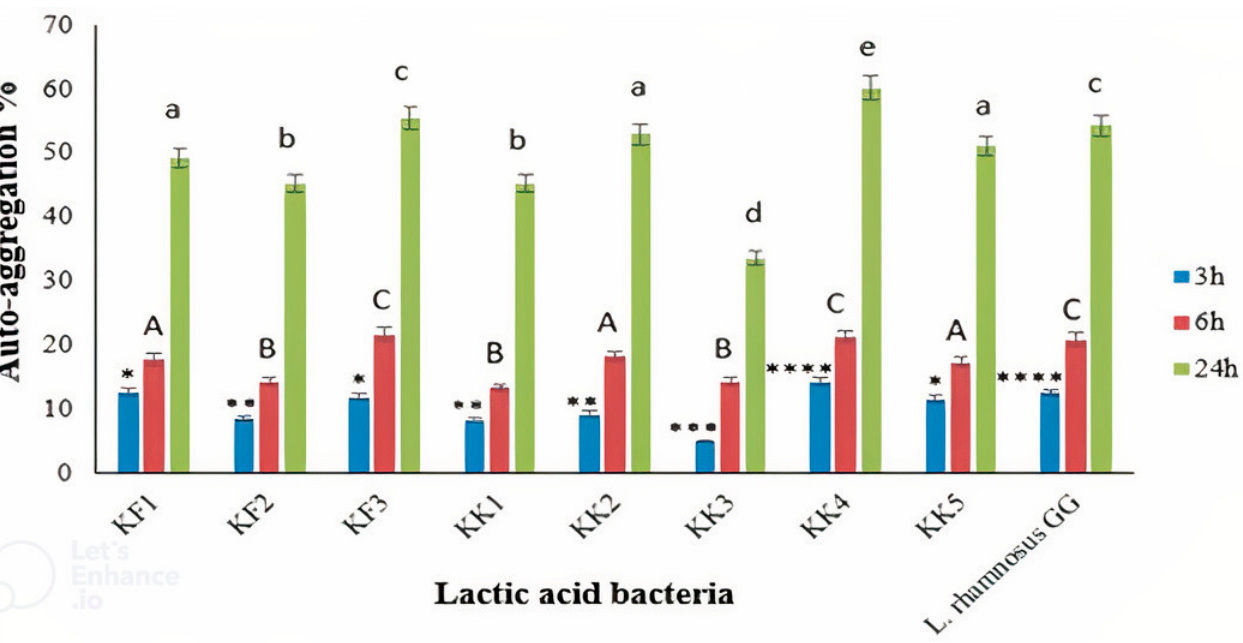
Figure 1. Cell surface hydrophobicity of the LAB isolates compared to the control strain, L. rhamno- sus GG. Different letters show significant differences ( p < 0.05)